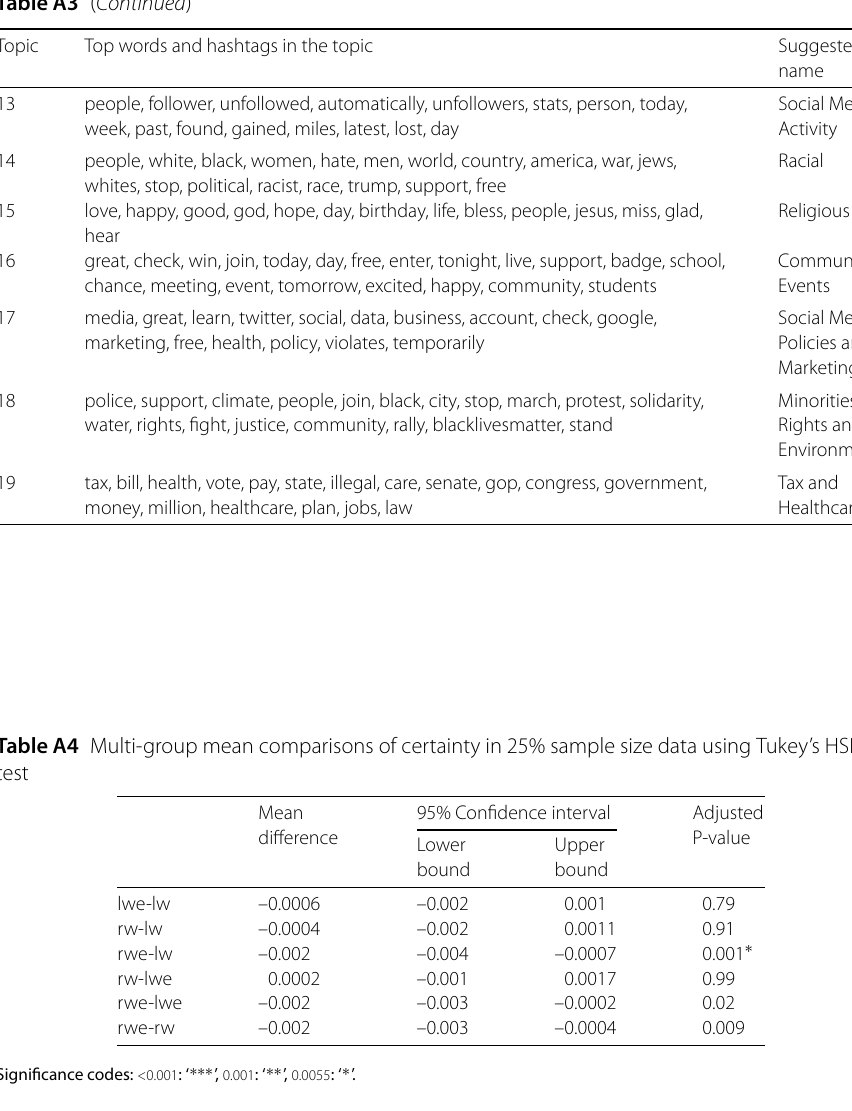
Table A5 Multi-group mean comparisons of anxiety in 25% sample size data using Tukey’s HSD test